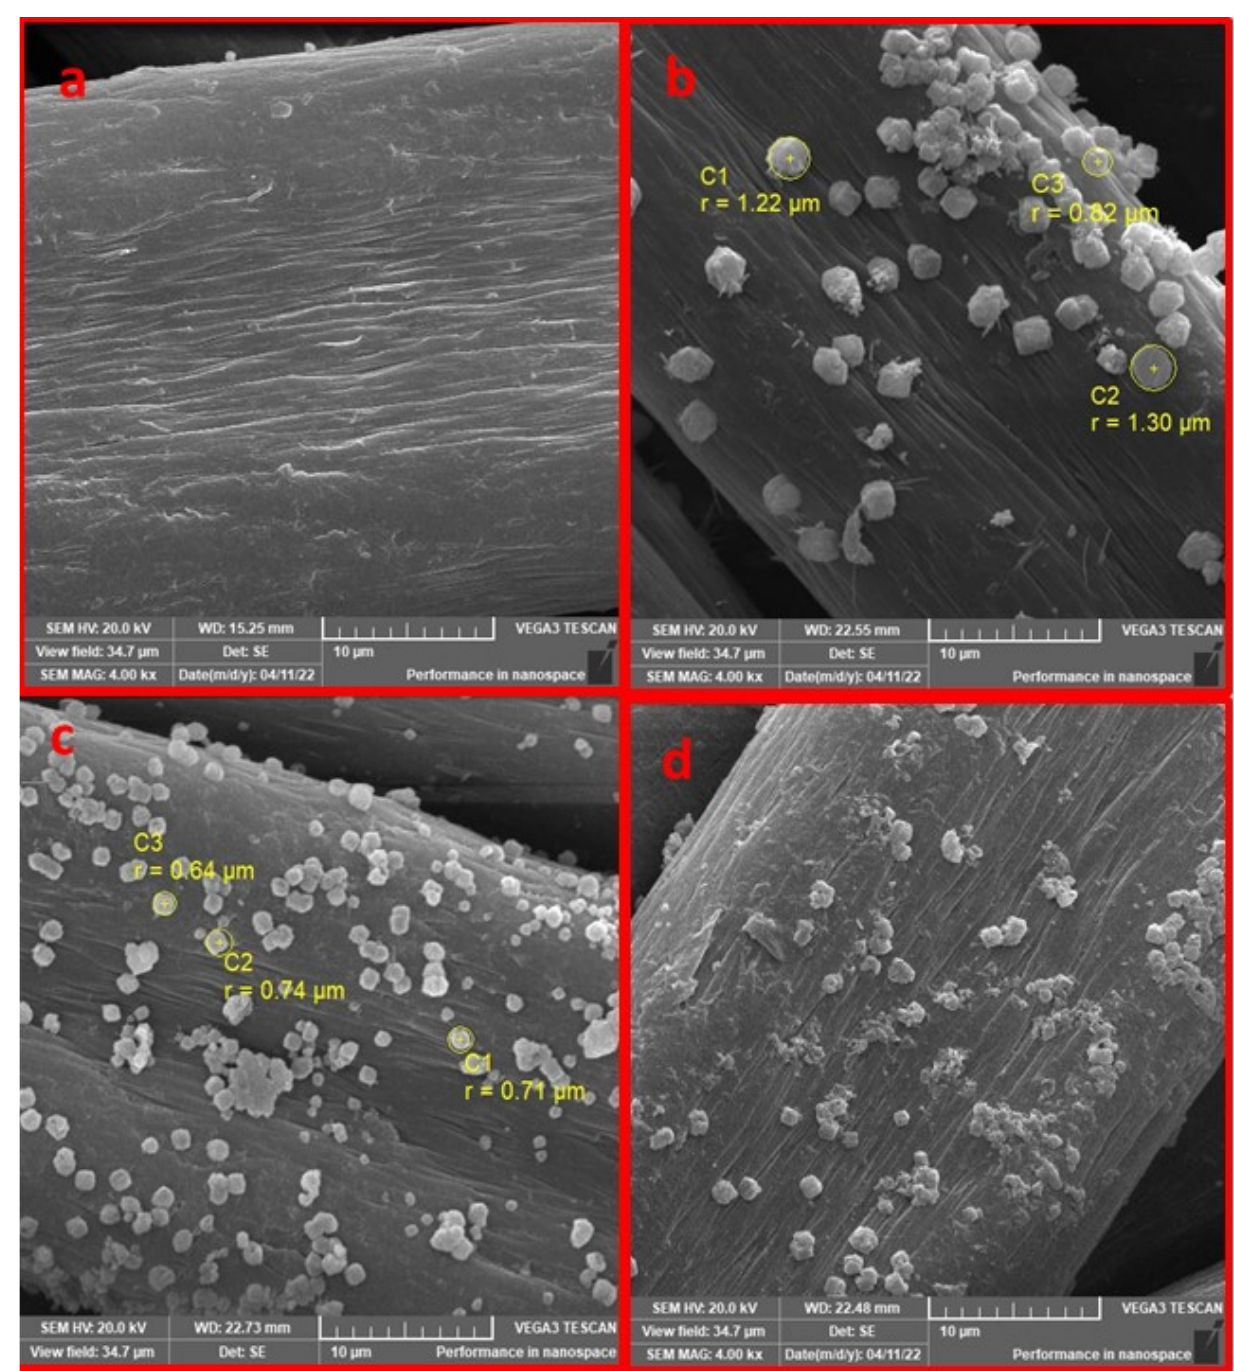
Figure 2. FESEM images of ( a ) pristine PAN, ( b ) PAN-HMDA, ( c ) PAN-HMDA-GL, and ( d ) PAN- HMDA-GL@Lipase.